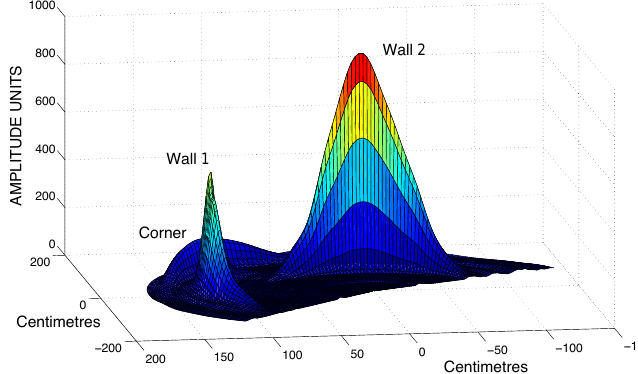
Figure 3. 3D representation of the intensity amplitude obtained from a corner. The figure shows that the corner-generator walls 1 and 2 return higher peak intensities than corner